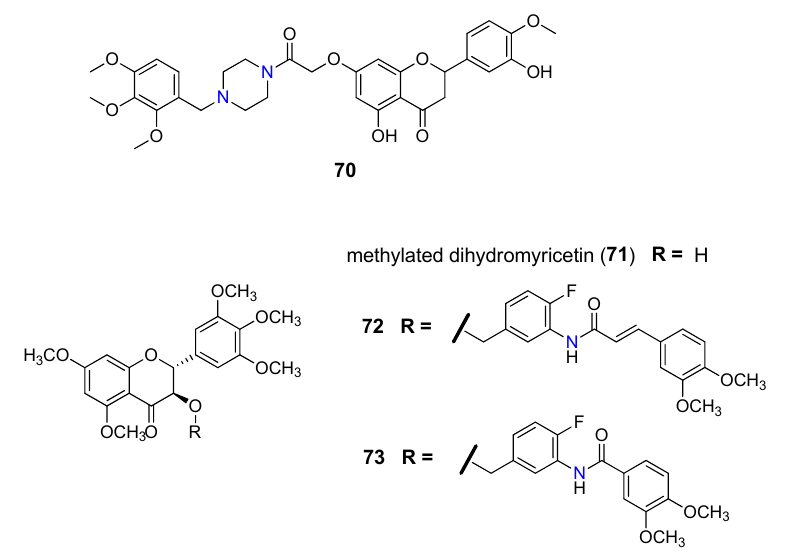
Table 6. Effects of flavone dimers 75 – 79 in modulating MDR in multidrug resistant cancer cells in vitro.